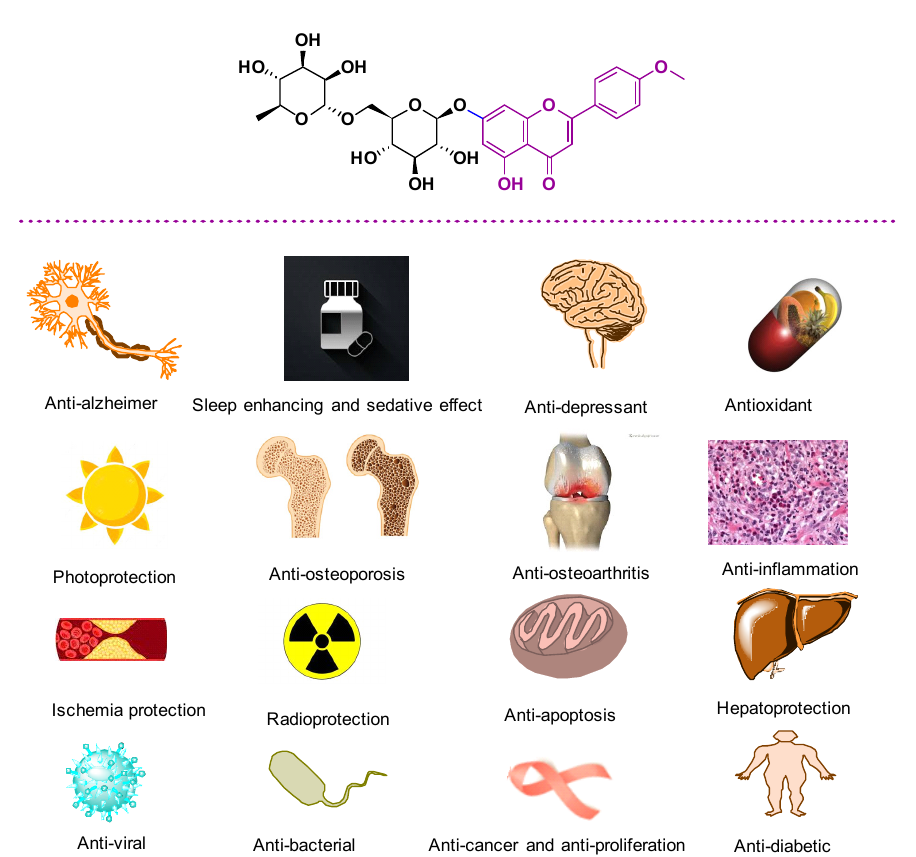
Figure 2. Summary of the biological activities of LN.